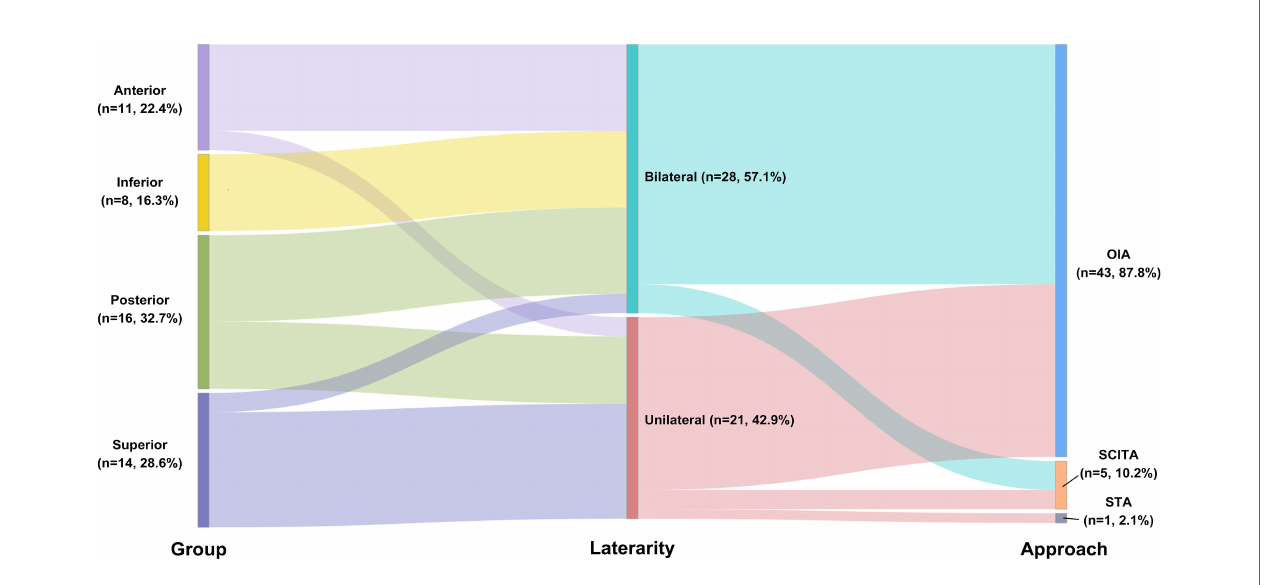
FIGURE 1 | Sankey diagram showing the relationship among location, Asari type, and surgical approach